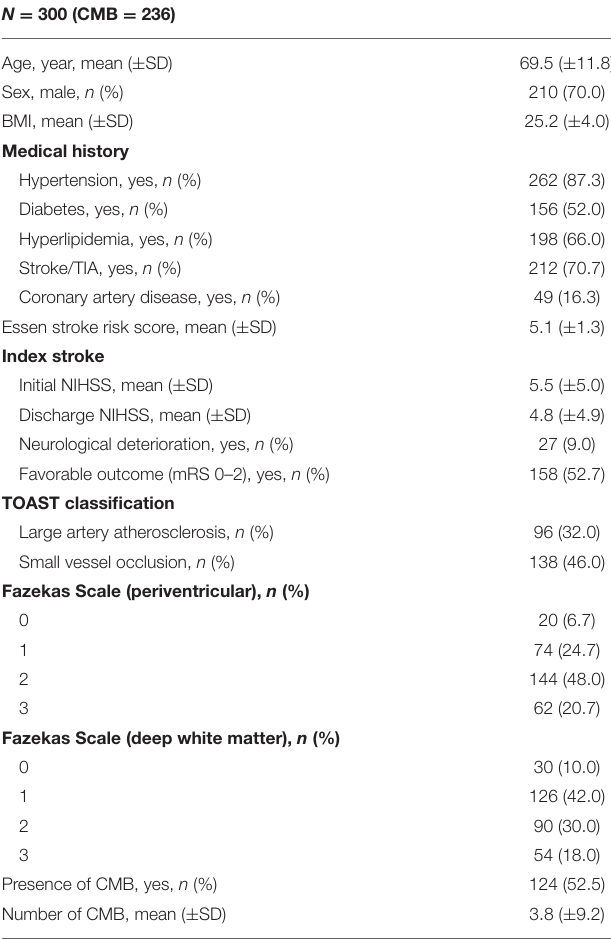
TABLE 1 | Demographic characteristics of the